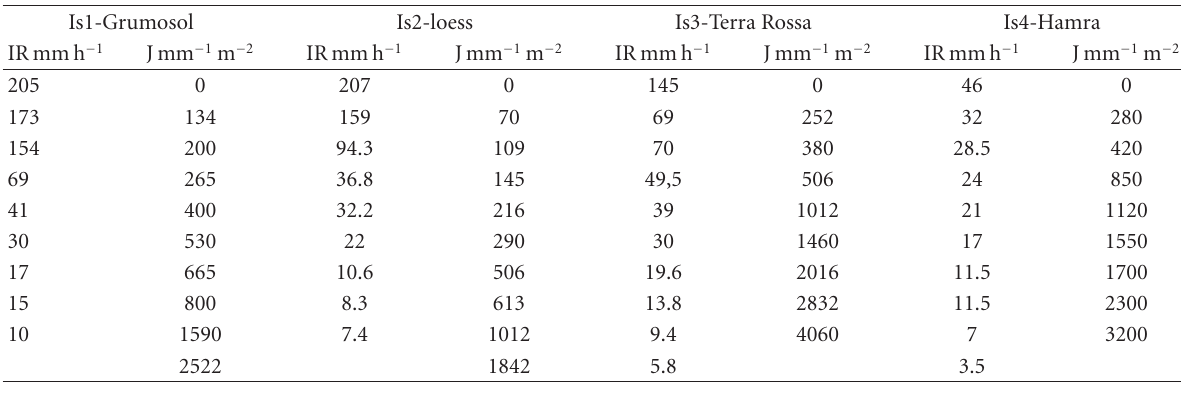
Table 2: Cumulative rainfall energies (Jmm − 1 m − 2 ) and subsequent infiltration rates (IR) for each soil: (a) Israeli soils. (b) US